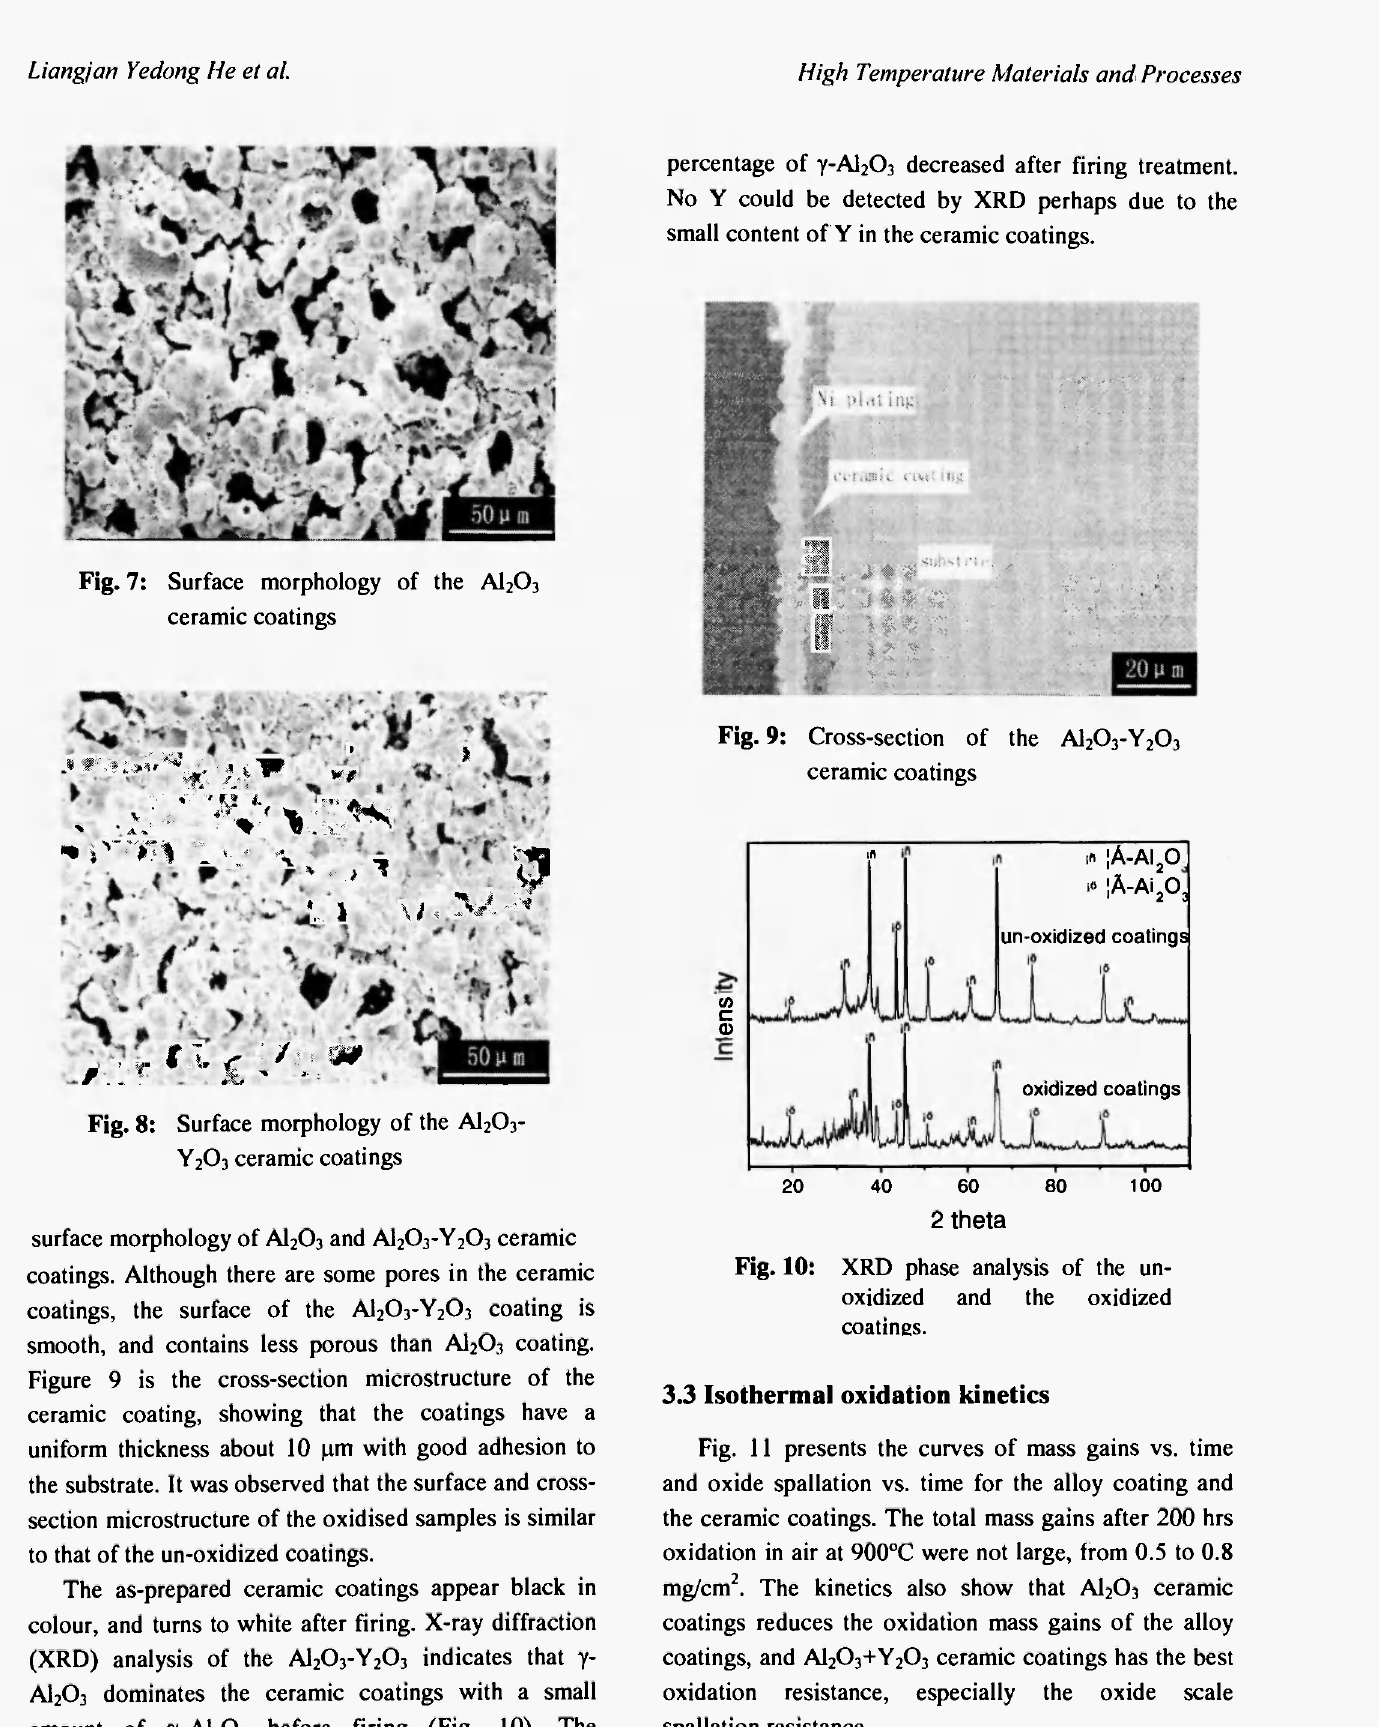
Y 0 ceramic coatings 2 3